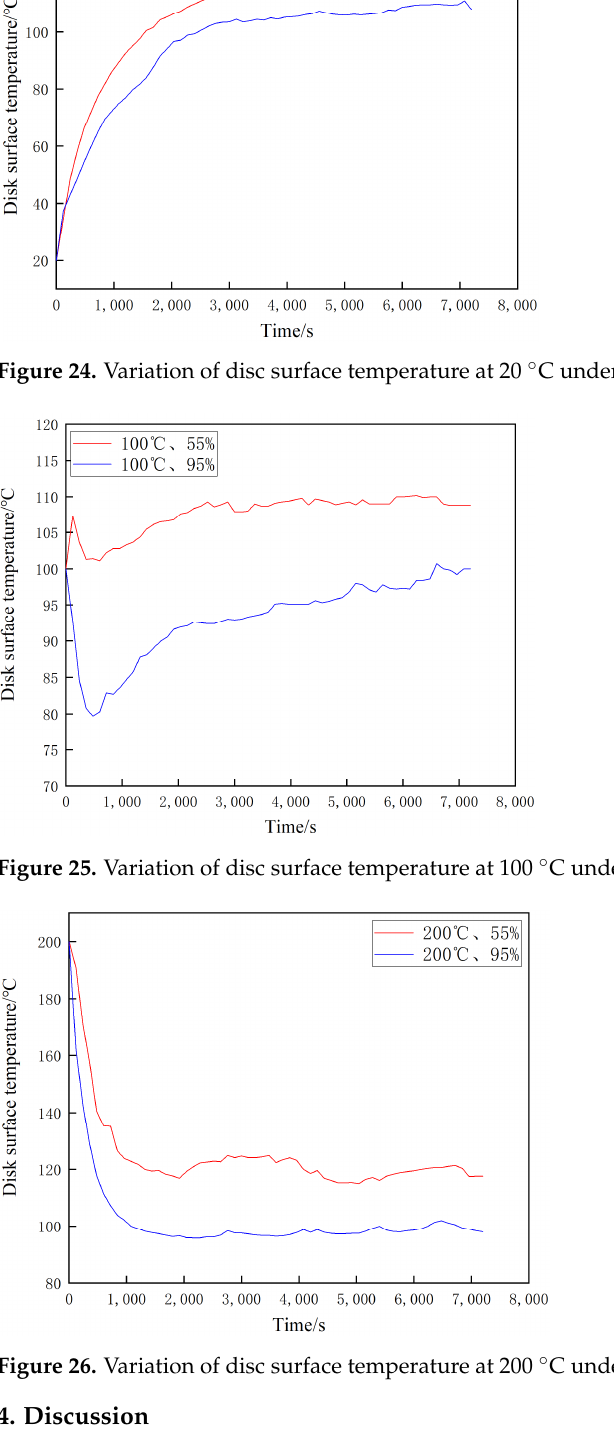
Figure 26. Variation of disc surface temperature at 200 °C under different ambient humidity.